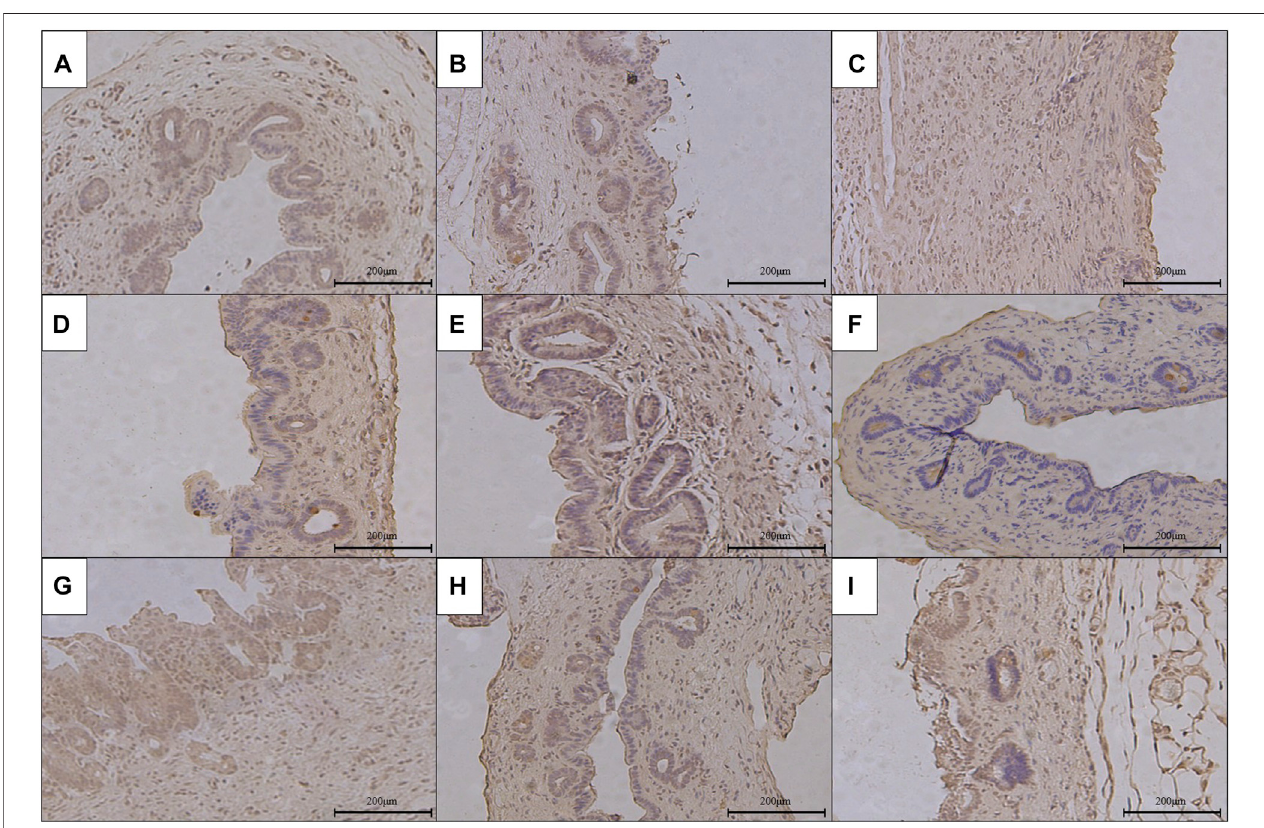
FIGURE 6 | Immunohistochemical staining of α -SMA in the anastomotic stoma after RCJS in different groups ( × 200). (A) IHC staining of α -SMA in the sham operation group. (B) IHC stainingof α -SMA inthe control group at 1 week after the RCJS procedure. (C) IHC stainingof α -SMAin the control group at 1 month after the RCJS procedure. (D) IHC staining of α -SMA in the anisodamine intervention group at 1 week after the RCJS procedure. (E) IHC staining of α -SMA in the anisodamine intervention group at 1 month after the RCJS procedure. (F) IHC staining of α -SMA in the neostigmine intervention group at 1 week after the RCJS procedure. (G) IHC staining of α -SMA in the neostigmine intervention group at 1 month after the RCJS procedure. (H) IHC staining of α -SMA in the combination group at 1 week after the RCJS procedure. (I) IHC staining of α -SMA in the combination group at 1 month after the RCJS procedure.